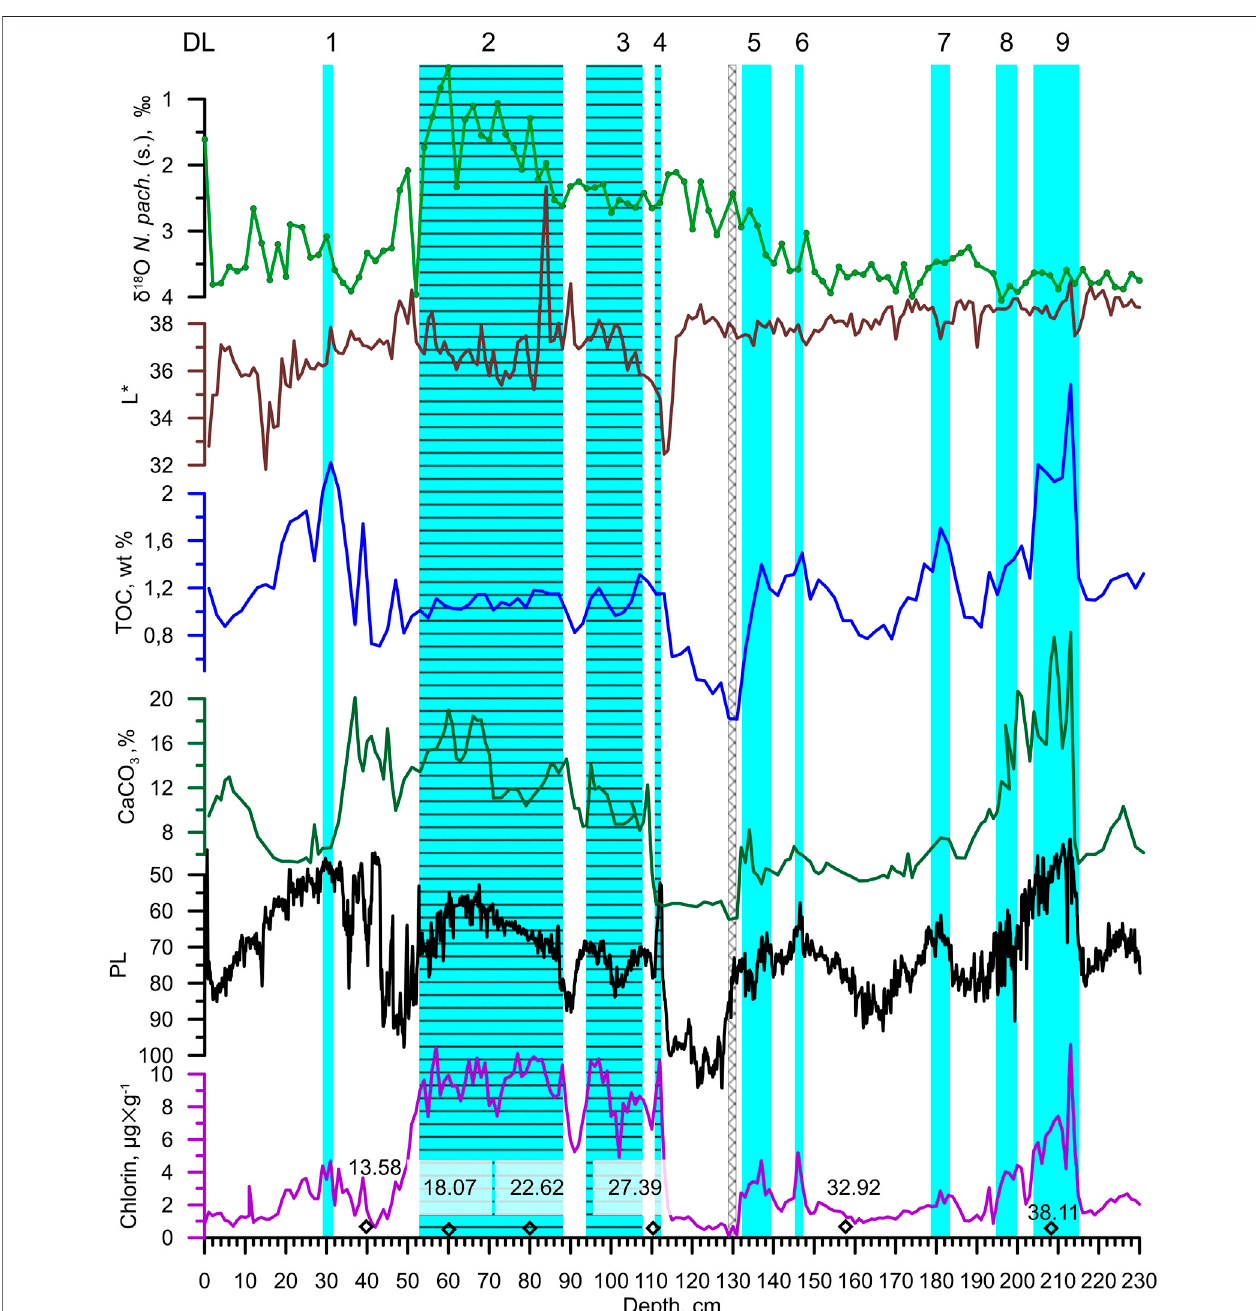
FIGURE 4 | Records of chlorin, total organic and carbonate content, number of planktic foraminifera per 1 g of dry sediments and δ 18 O of planktic foraminifera N. pachyderma (s.) in sediment core LV53-23-1 versus depth. Diamonds indicate AMS 14C data (cal. ka). Notation of bars and DL number is the same as in Figure 3 .